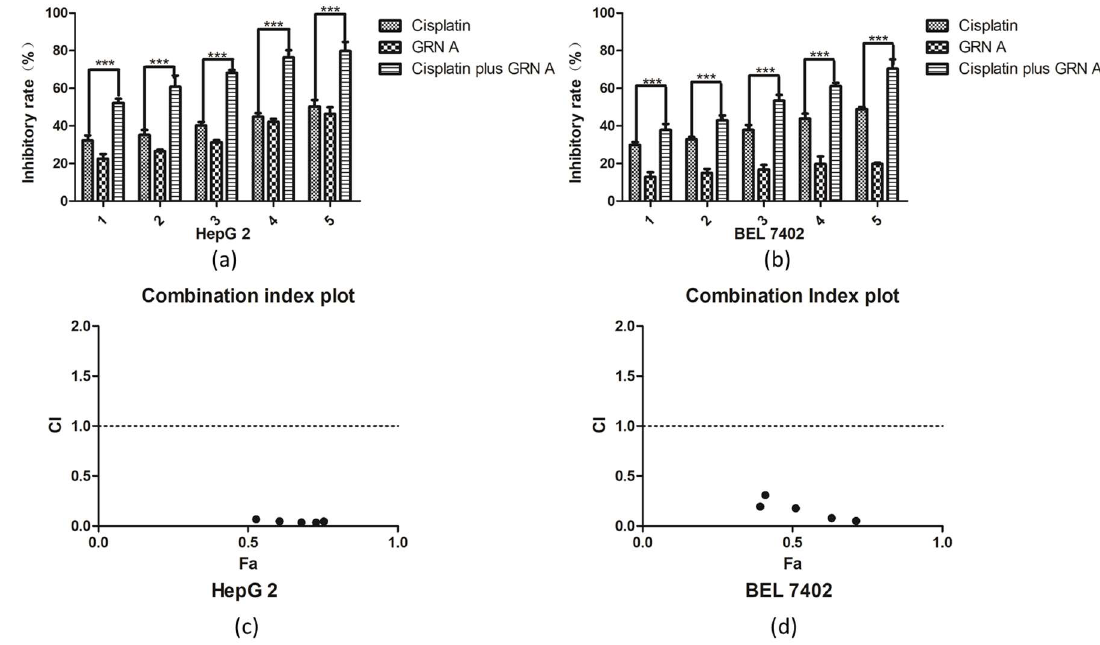
Figure 1. GRN A synergized with cisplatin to inhibit cancer cell proliferation. Cytotoxicity of GRN A, cisplatin, and the combination of the two drugs. HepG2 ( a ) and BEL7402 ( b ) cancer cells were plated on 96 plates. After an incubation for 48 h, cells were treated with certain concentrations of GRN A, cisplatin, and the combination of the two drugs. The inhibitory rate of the cell growth was analyzed by an MTS assay, as described in the materials and methods section. ( c , d ) Combination index (CI) Plot. A CI of GRN A and cisplatin was analyzed using the Chou-Talalay approach. CI values were plotted as a function of the fractional affection (Fa) from 0.39 to 0.85 in HepG2 and BEL7402 cells. CI >